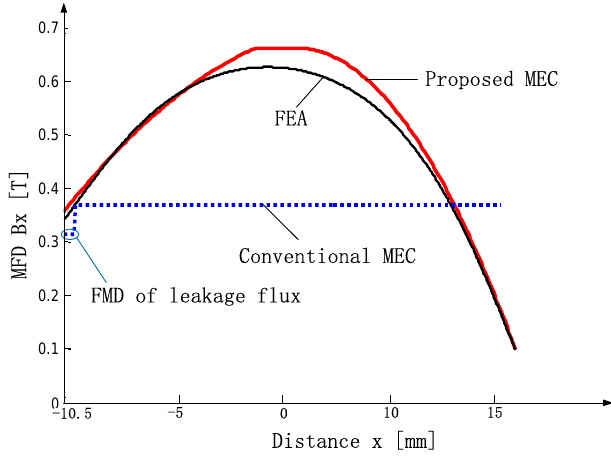
versus x with g = 12 mm, t = 3.5 g1